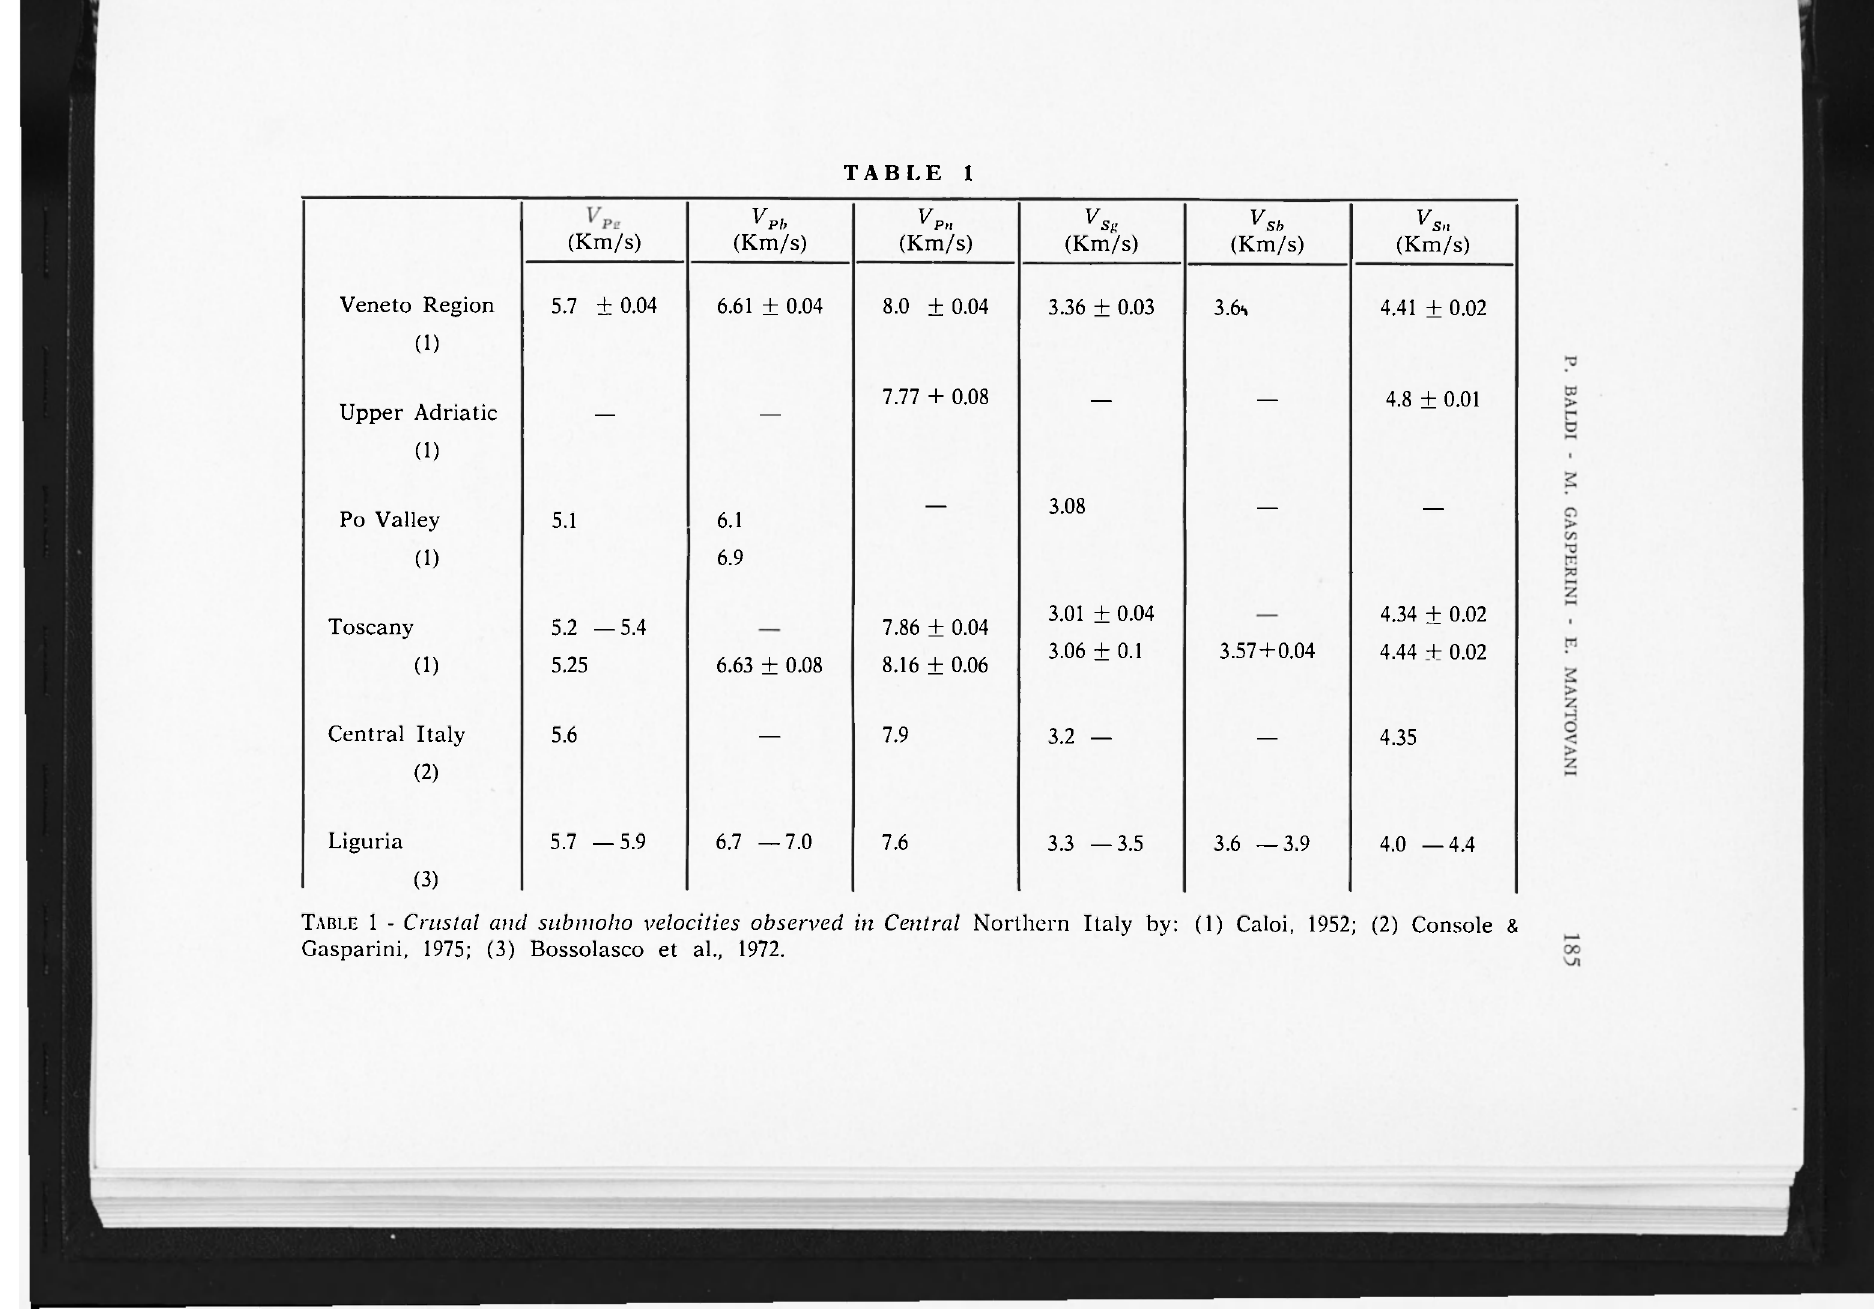
TABLE 1 - Crustal and submoho velocities observed in Central Northern Italy Gasparini, 1975; (3) Bossolasco et al.,